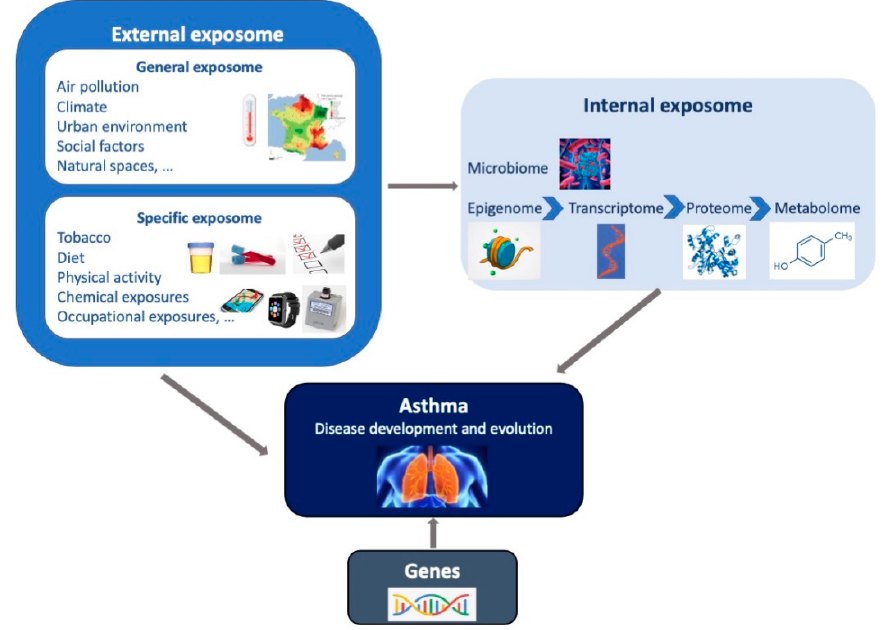
Figure 1. Representation of the exposome concept. The exposome represents the totality of human environmental exposures from conception onwards, complementing the genome. The exposome is composed of three domains (general external, specific external and internal) which may interact together and with genetic factors, to impact on the asthma development and on the manifestation of the disease among individuals with asthma.